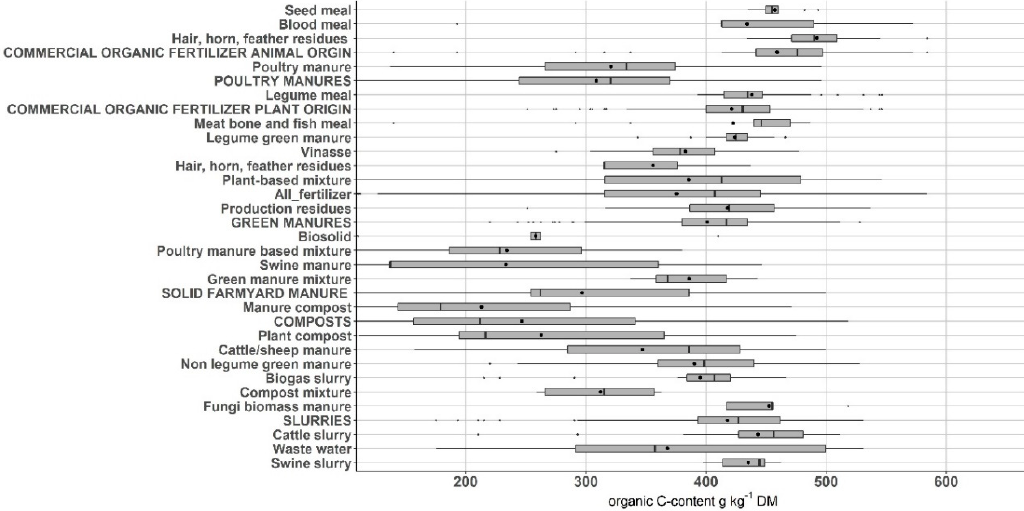
Figure 2. Boxplot of organic C in the fertilizer main groups (capital letters) and subgroups. The circles are means and the stripes are the medians of the observations.